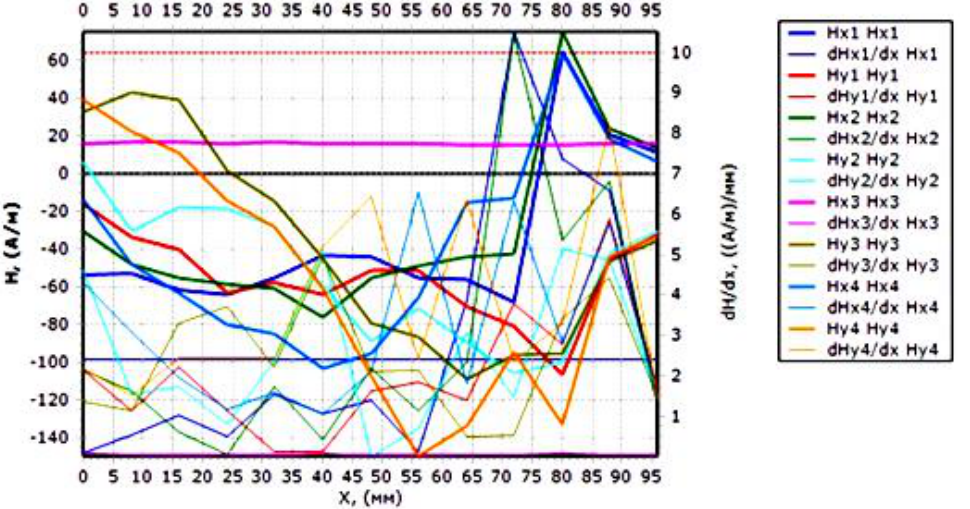
Figure 7. Graph of stress concentration zones in the wheel.